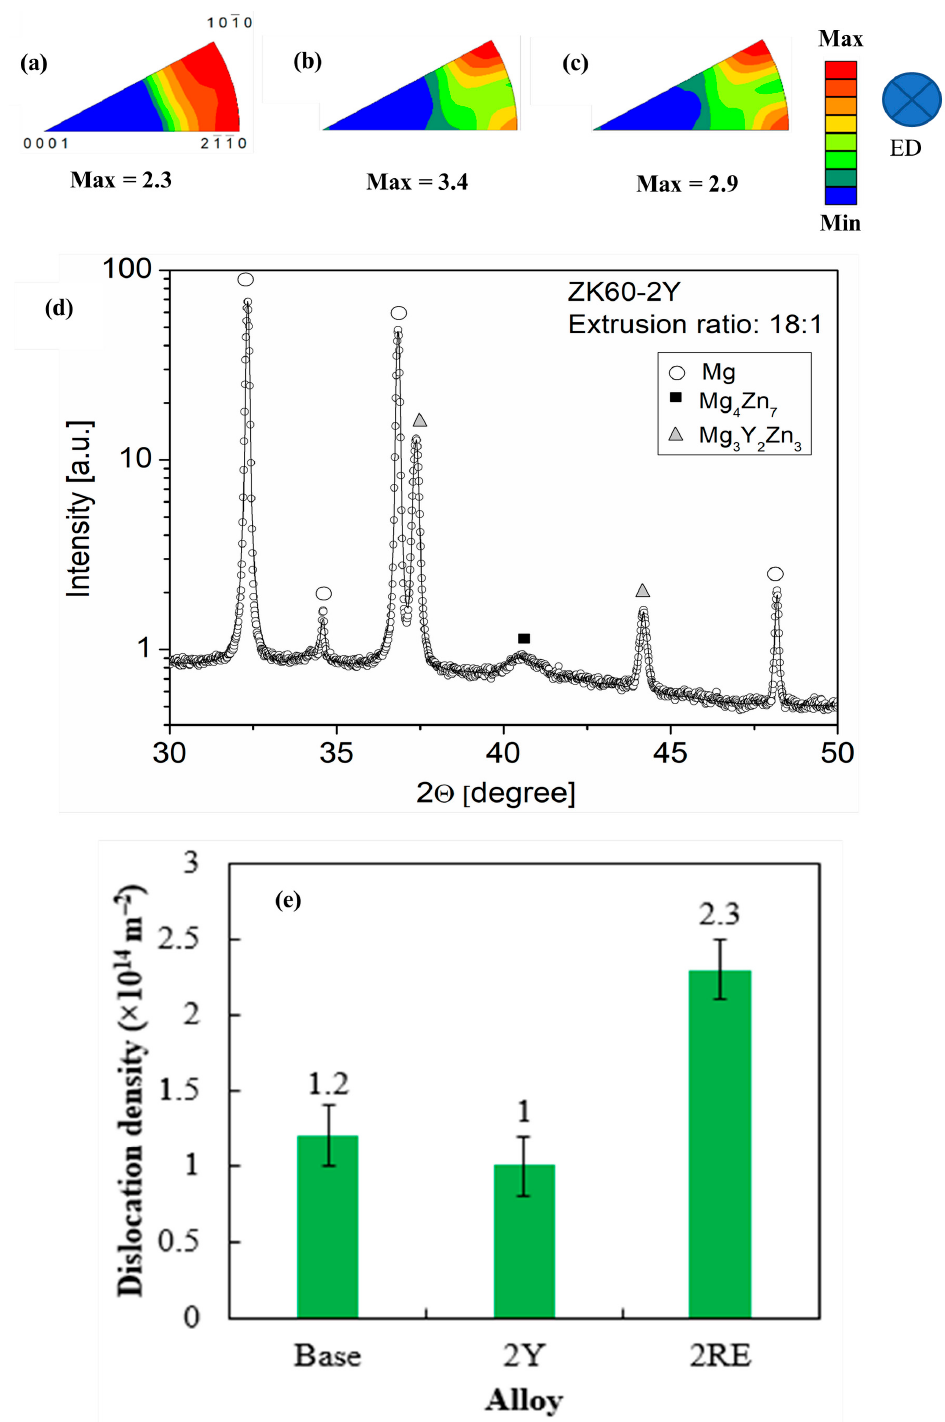
Figure 5. Inverse pole figures for ( a ) ZK60, ( b ) ZK60–2Y, and ( c ) ZK60–2RE alloys, and ( d ) CMWP fitting for the extruded ZK60–2Y alloy. The open circle and the solid line represent the measured data and the fitted XRD pattern, respectively. The intensity is in a logarithmic scale. ( e ) The dislocation density for the three studied alloys determined by CMWP